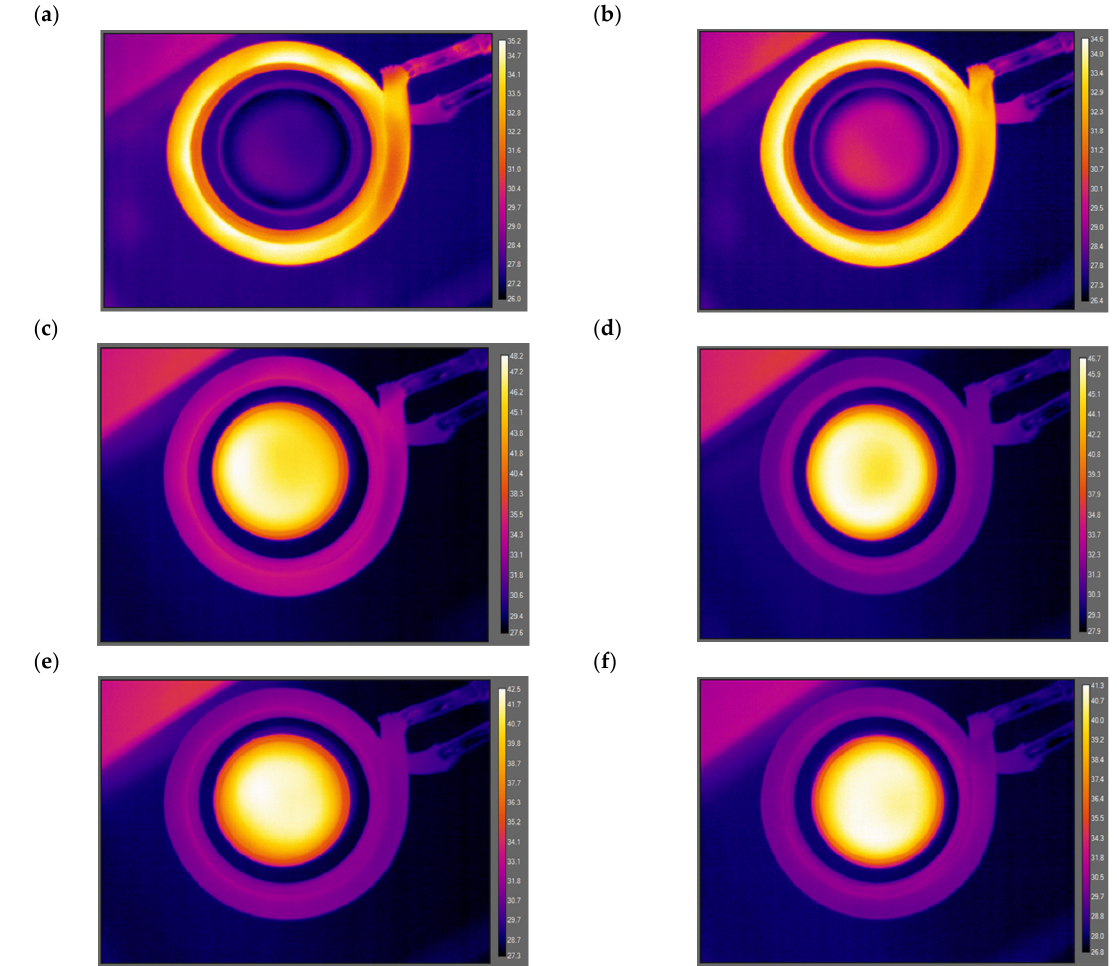
Figure 13. SPION/HAP under the AMF 540 kHz, 21 G, after ( a ) 5 s, ( b ) 30 s, ( c ) 90 s of AMF with retain 6 G, ( d ) 19 G, ( e ) 17 G, and ( f ) 15 G. The change of the temperature in the function of time for the SPION/HAp under the AMF with the frequency of 540 kHz and the amplitude of approximately 15 G, 17 G, 19 G, and 21 G is presented in Figure 14. The measurements were performed for 10 min, where the amplitude of the AMF was varied. Depending on the concentration of the nanocom- posite, the heating temperature slightly varied, while in both cases of 15 mg mL − 1 and 20 mg mL − 1 , the therapeutic temperature was reached. The results are comparable with the nanocomposite based on SPIONs and HAp in a different ratio [49].